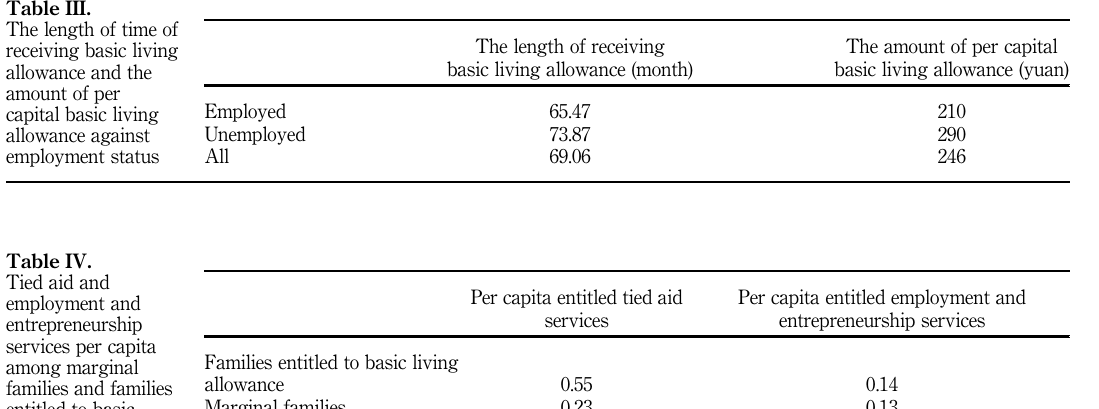
Table III. The length of time of receiving basic living allowance and the amount of per capital basic living